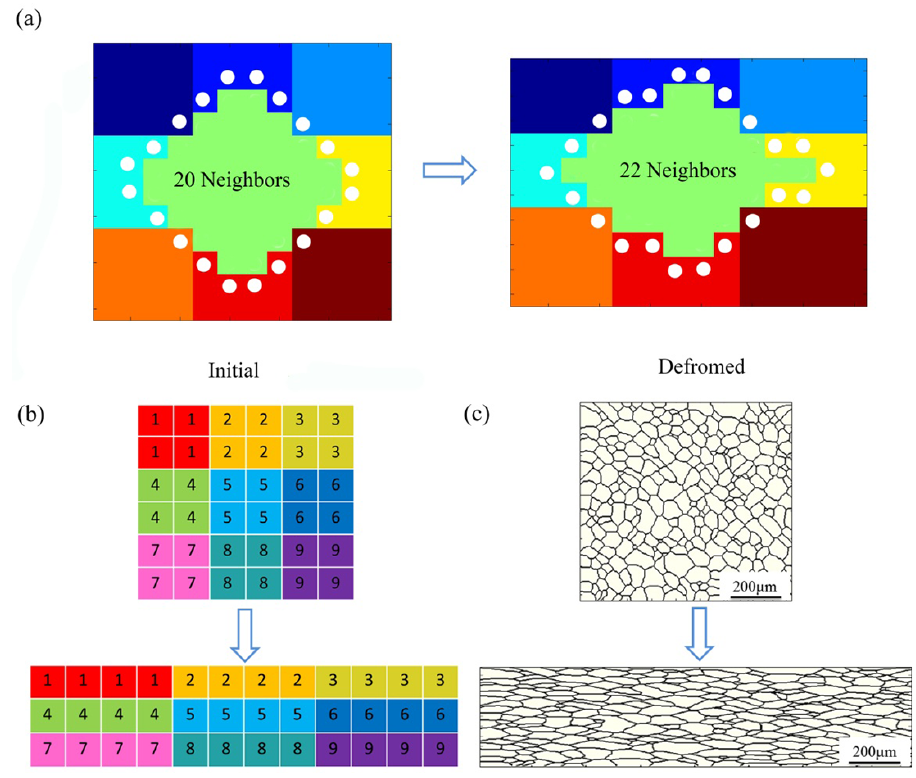
Fig. 2. Schematic diagram of grain topology with matrix deformation: (a) schematic diagram of geometry change due to matrix deformation, (b) schematic diagram of matrix deformation, e e =0.5, (c) grain topology induced by matrix deformation, e e =0.5, (initial average grain size d 0 =44.5 m Figure 2b show the schematic diagrams of matrix deformation and grain topology under certain strain.